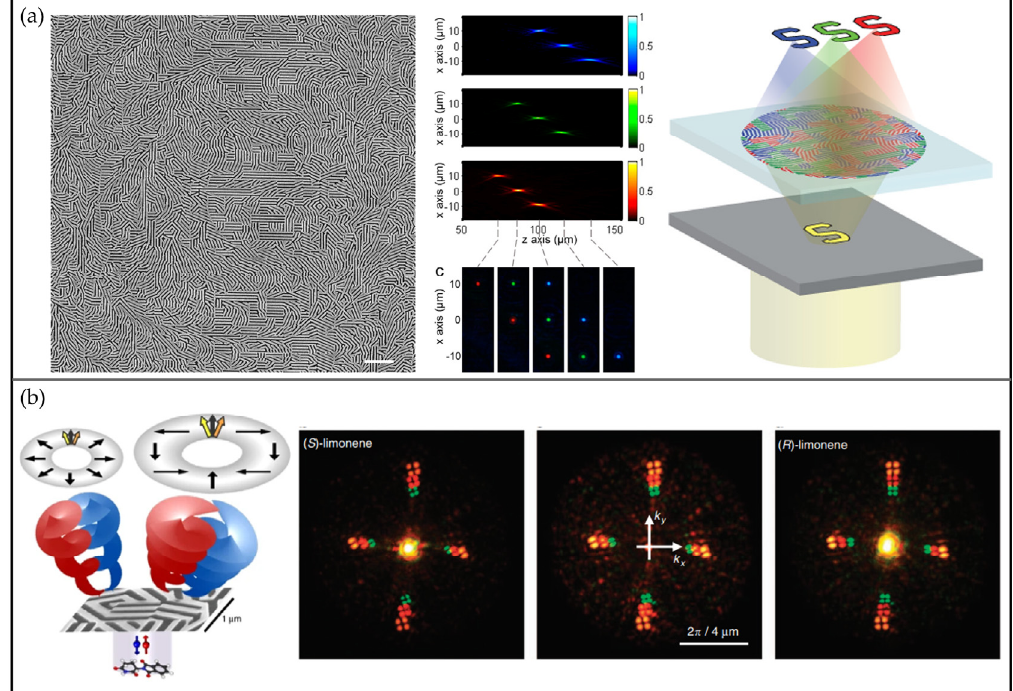
Figure 3. The interleaved metasurfaces: ( a ) Interleaved Si-gradient metasurface create axial and lateral multifocal geometric-phase metalenses, achieving multiwavelength color imaging. Reprinted with permission from [40]. Copyright 2016, American Chemical Society. ( b ) The schematic diagram of the Si geometric-phase metasurface integrates spectropolarimetry and OAM sensing, and diffraction patterns of interleaved vectorial vortices generated by using linearly polarized light passing through (S)-limonene, air, and (R)-limonene. Reprinted from [70]. Copyright © 2017, The Author(s).